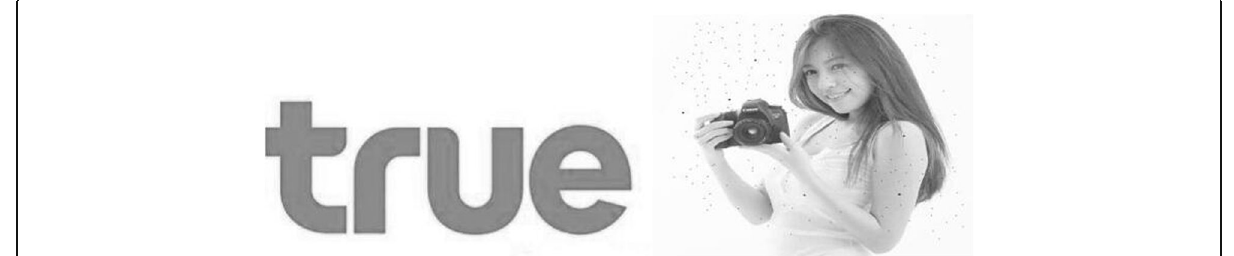
Fig. 11 Attacked with salt and pepper noise and extracted hidden image (Example